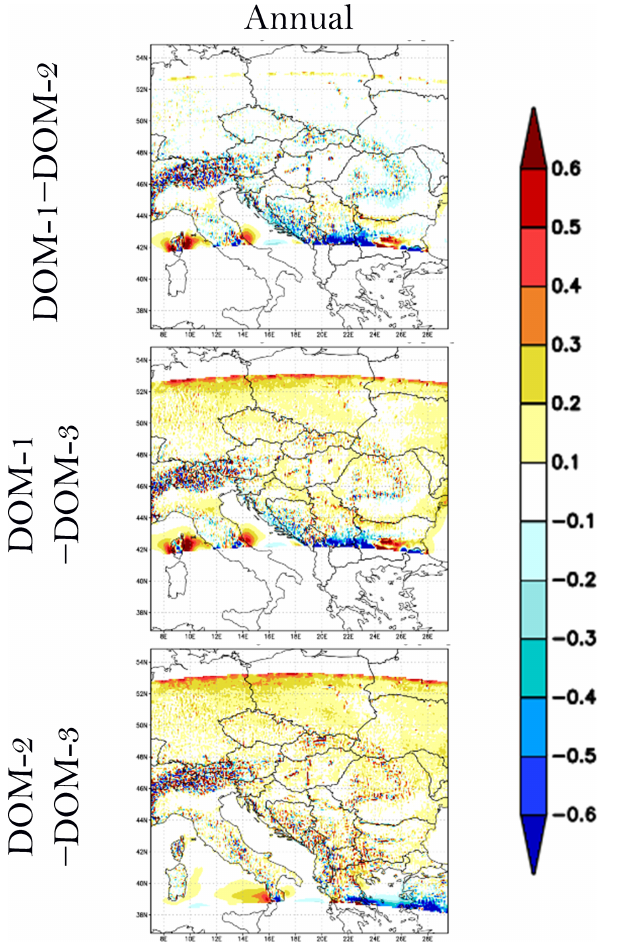
Figure 3. Difference ( ◦ C) of the annual simulated temperature per- formed on the different domains. Period: